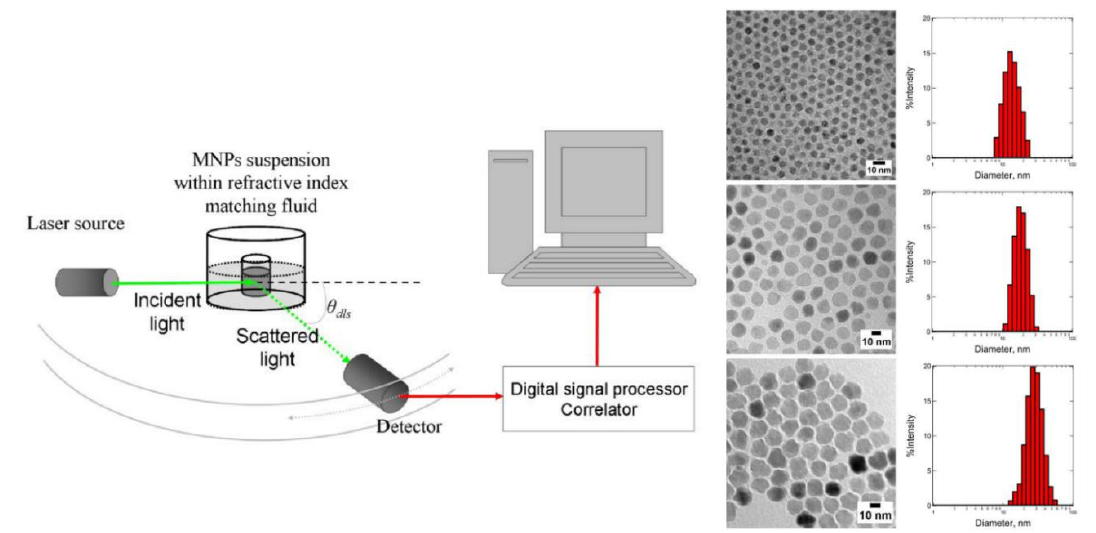
Figure 20. Left : schematic representation of the experimental setup for dynamic light scattering measurements. Right : TEM micrographs of Fe 3 O 4 magnetic nanoparticles with the corresponding size distribution determined by DLS. The Z-average of magnetic nanoparticles measured by DLS is 16.9 ± 5.2 nm (top), 21.1 ± 5.5 nm (middle), and 43.1 ± 14.9 nm (bottom), respectively. Reproduced with permission from [228] (published by Springer Open, 2013) licensed under CC BY 2.0.